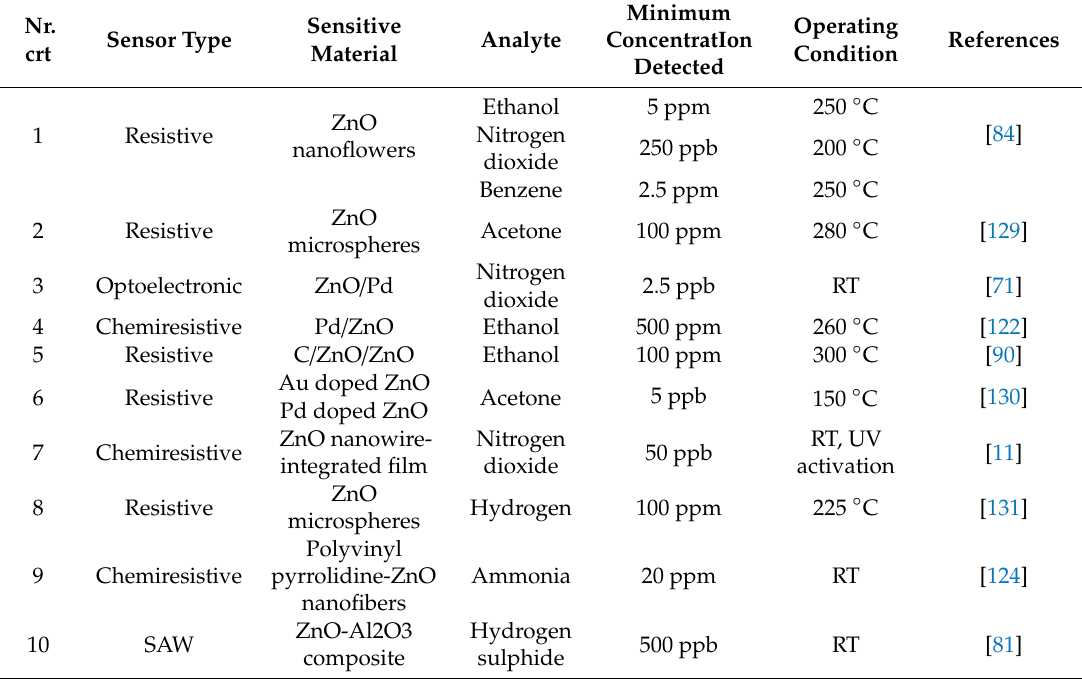
Table 1. Types of ZnO based